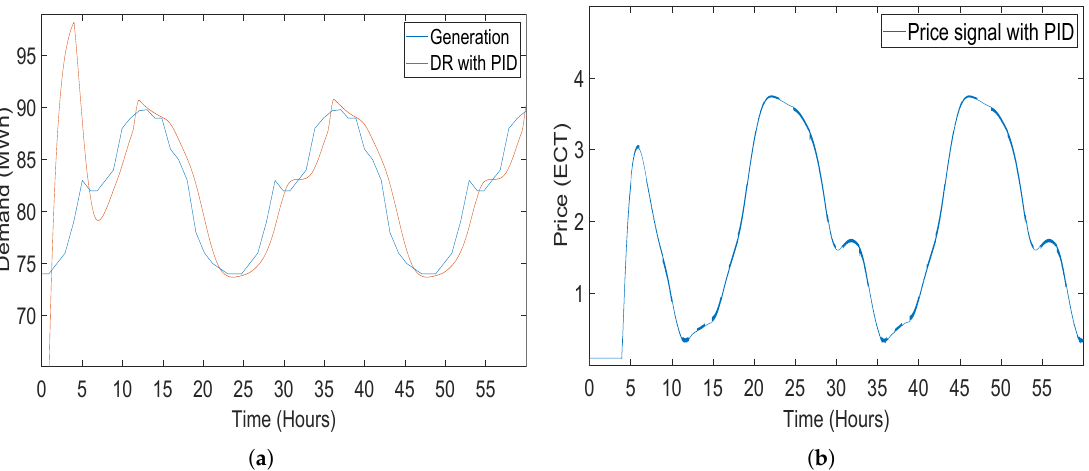
Figure 16. Closed-loop elastic demand control using a proportional integral derivative (PID) controller having coefficient values K p = − 1, K p = − 2 and K d = − 3: ( a ) demand response; ( b ) price response.